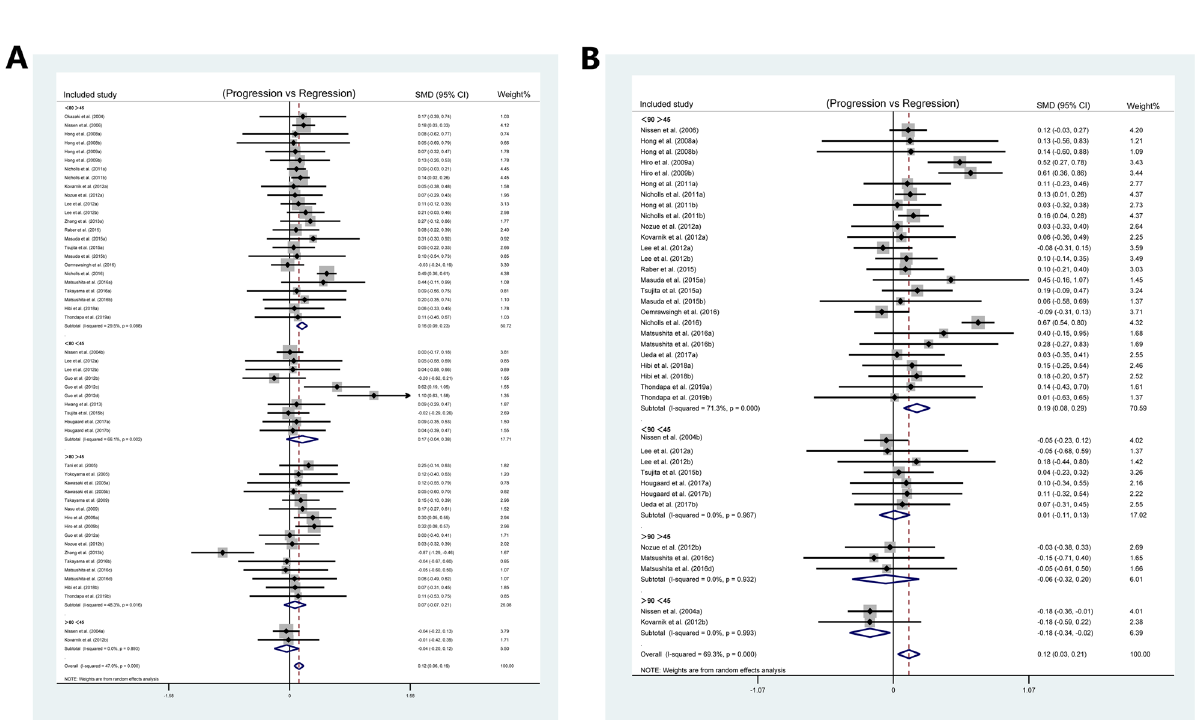
Figure 3. Subgroup analysis for SMD in plaque volume between patients at baseline and follow-up: ( A ) subgroup analysis of TAV according to the different levels of LDL and HDL; ( B ) subgroup analyses of PAV according to the different levels of LDL and